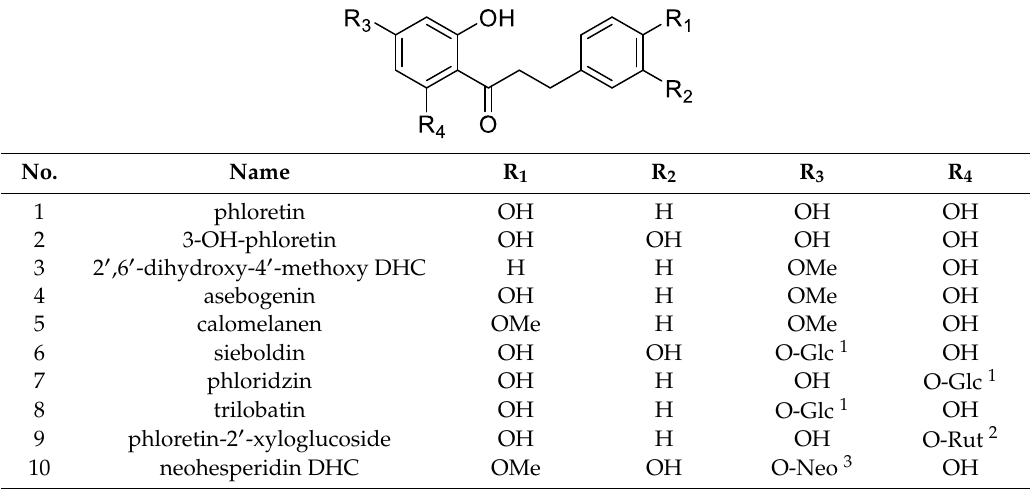
Table 1. Compounds 1 – 10 , which were used for the biological evaluation.